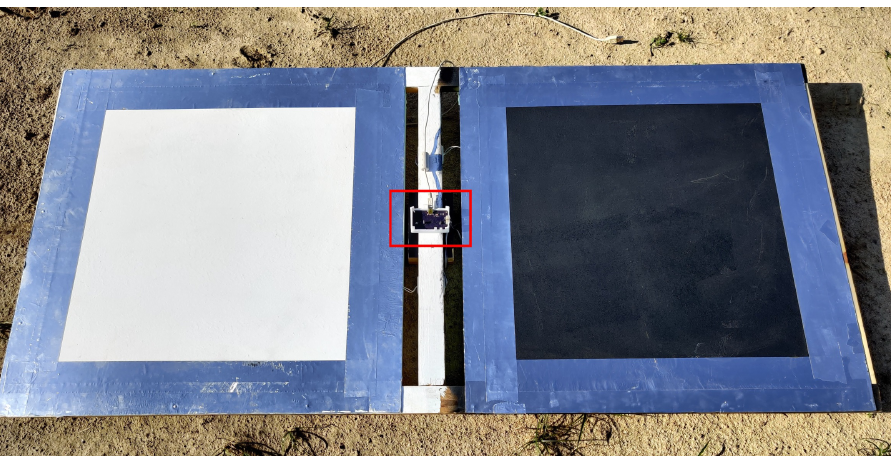
Figure 7. Thermal calibration targets. The customized device to record atmospheric conditions (highlighted by red rectangle) was mounted between the calibration